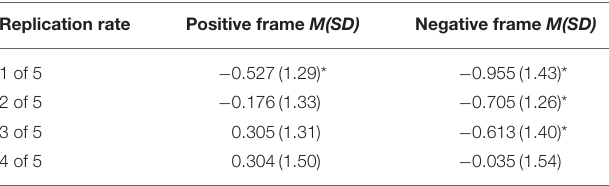
TABLE 6 | Mean and standard deviation of difference scores for Experiment 4.